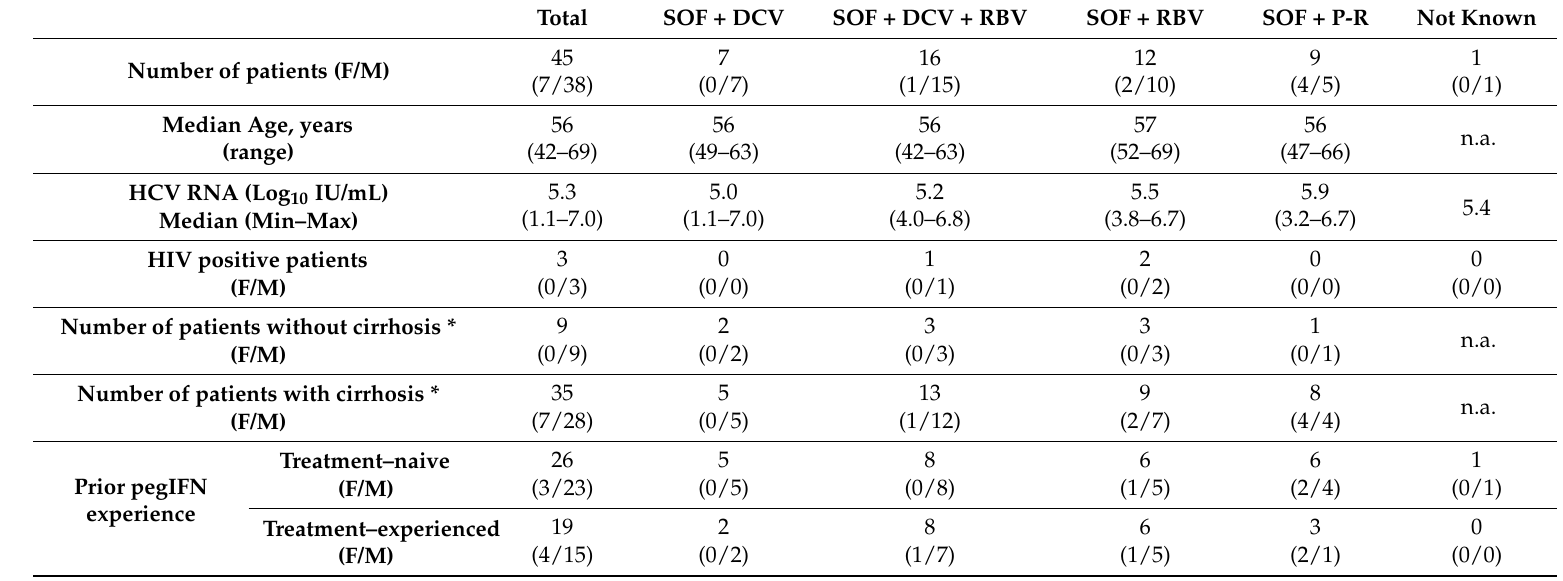
Table 1. Baseline demographics and disease characteristics of the study